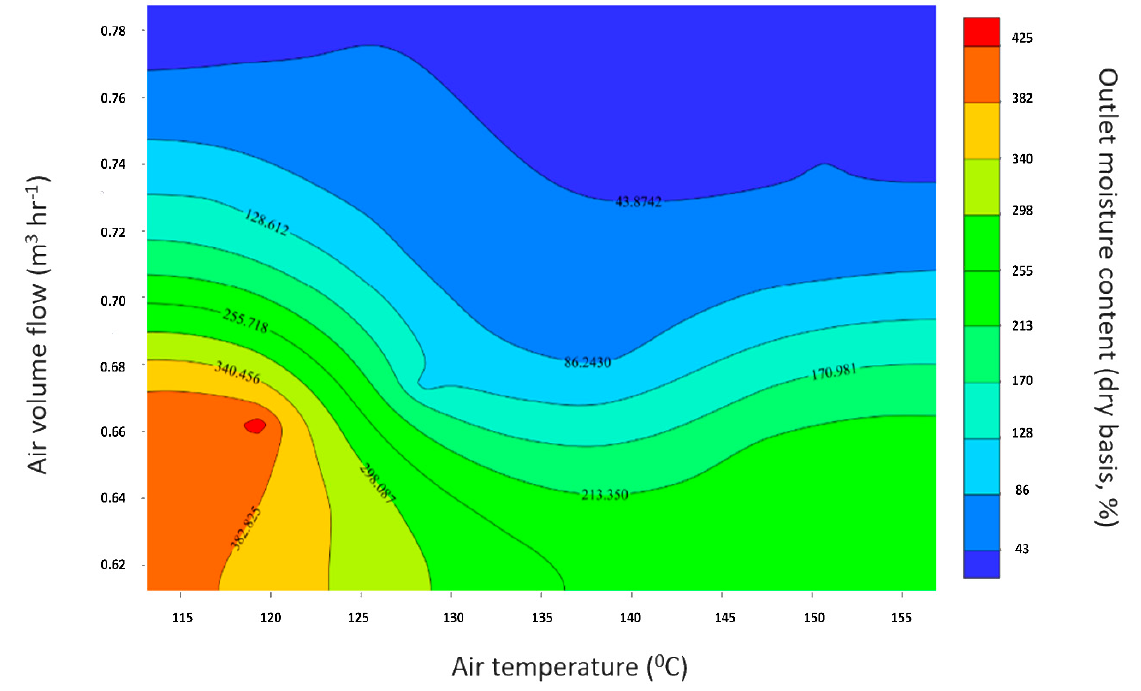
Figure 10. Contour sensitivity analysis diagram of the spray drying model .